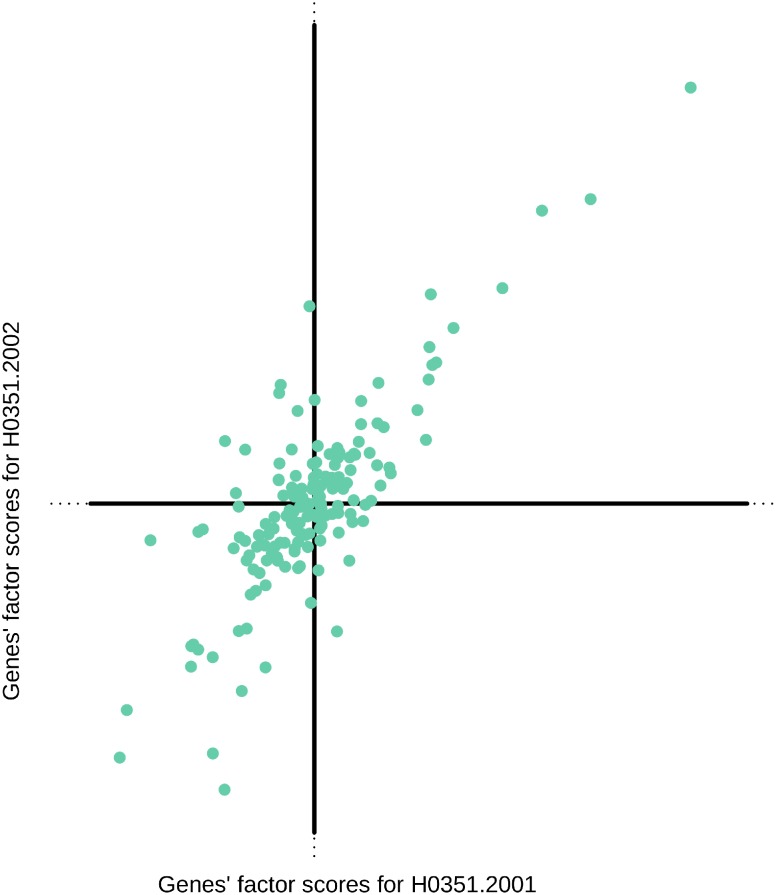
Scatter plot of the gene factor scores of the discriminant dimension extracted by the DiCA analyses performed on the 161 genes measured on Specimens H0352001 (horizontal) and H0352002 of ABA.Each dot represents one of the 161 genes. The coefficient of correlation is equal to .90 (r
2 = .81, p<.001).